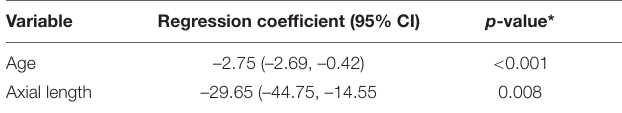
TABLE 2 | Association of corrected subfoveal choroidal thickness (SFCT) with age and axial